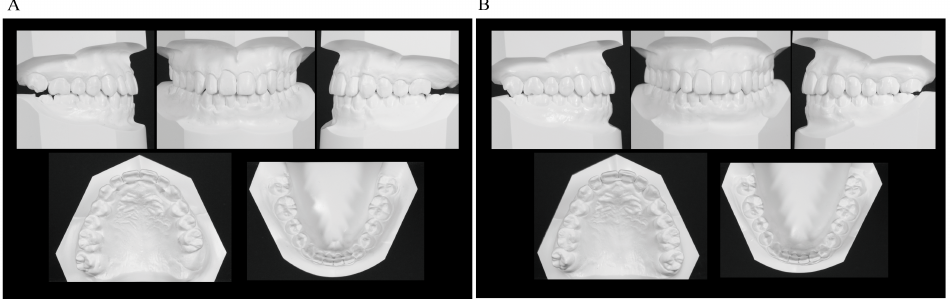
Figure 8. Dental casts. ( A ) At termination of active treatment (age, 17 years 9 months). ( B ) At completion of eruption of the maxillary left third molar (age, 21 years 3 months).